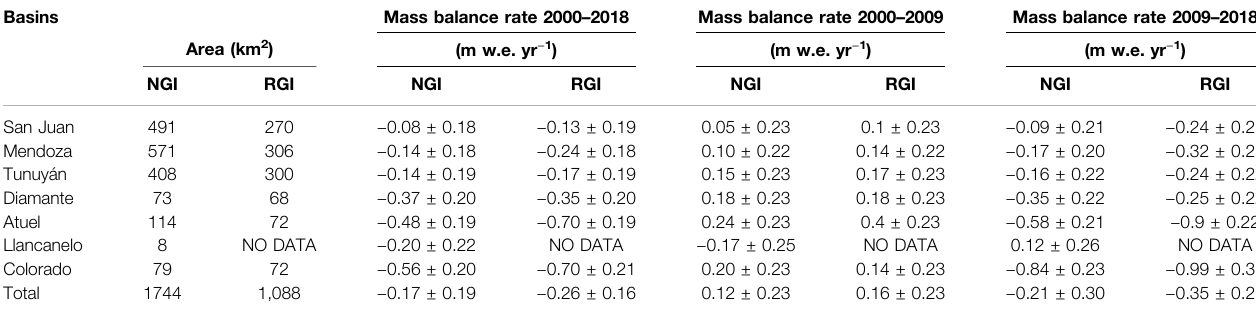
TABLE 3 | Mass balance rates calculated for the main river basins using the RGI version 6.0 and NGI datasets and different time periods. Basins